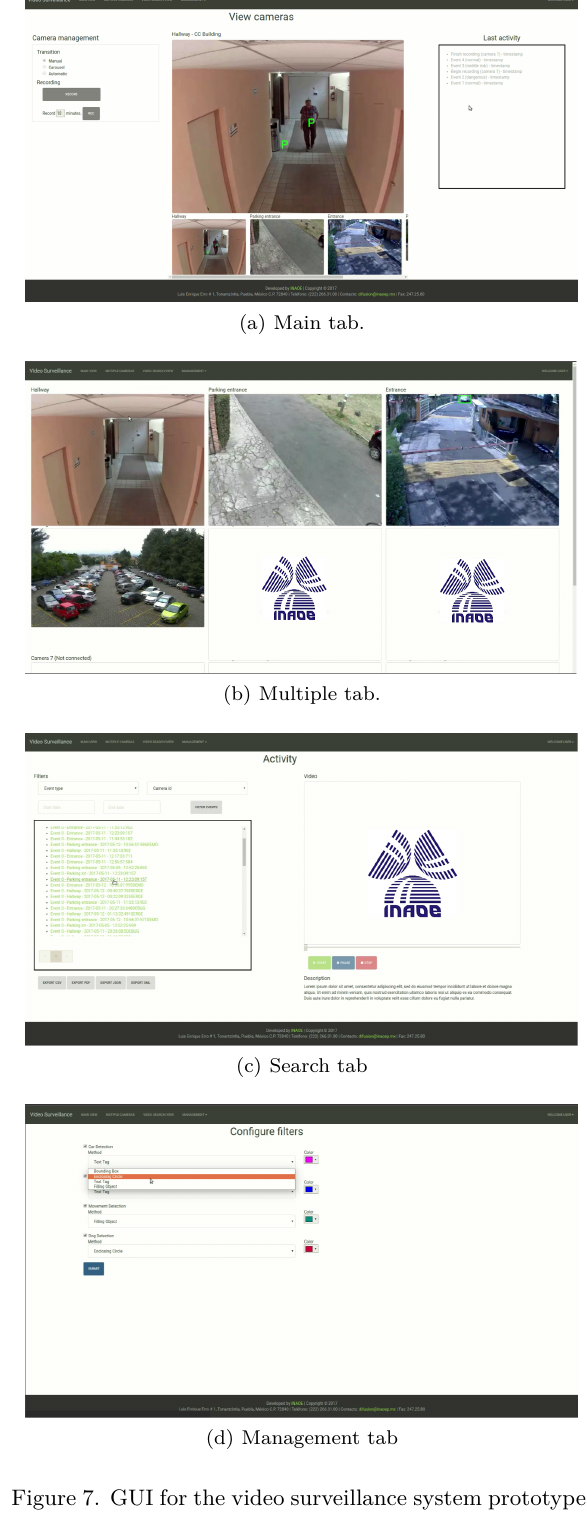
Figure 7. GUI for the video surveillance system